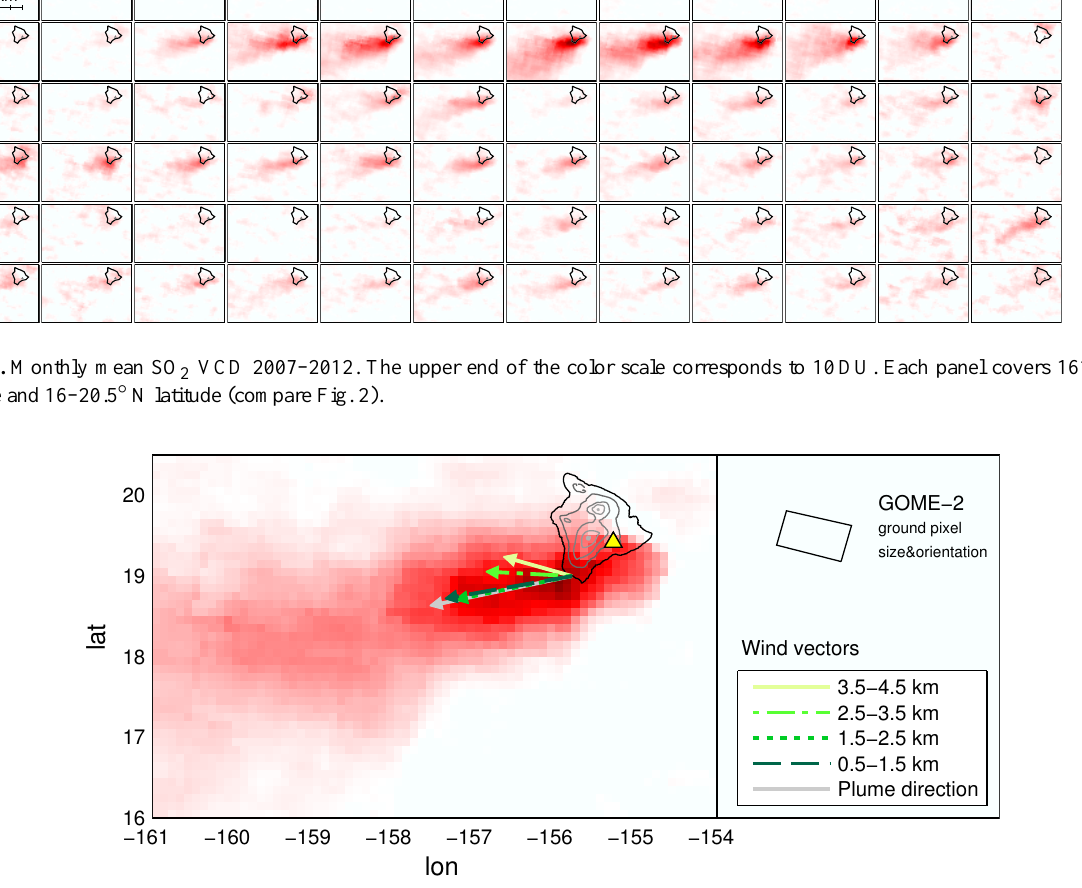
Figure 2. Monthly mean SO 2 VCD for August 2008. Color bar as in Fig. 1. Kılauea on Hawai‘i Island is indicated by a triangle. The grey lines show surface elevation contours in 1km intervals. The main plume direction is indicated by a grey arrow, while the mean ECMWF wind vector for different altitudes is plotted in shades of green (a vector length of 1 ◦ corresponds to a velocity of 5ms − 1 ). As transport on Hawai‘i Island is strongly affected by topography, the southwestern tip of the island was chosen as the origin. The size and orientation of an individual GOME-2 groud pixel is indicated in the